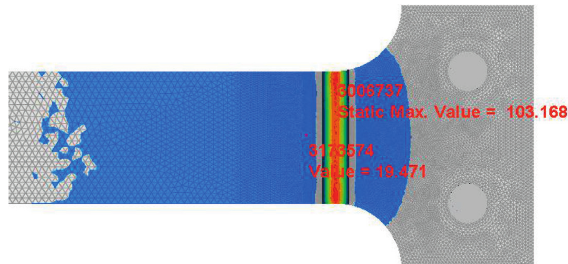
Figure 11: Calculation of the stress concentration factor (unit: MPa).